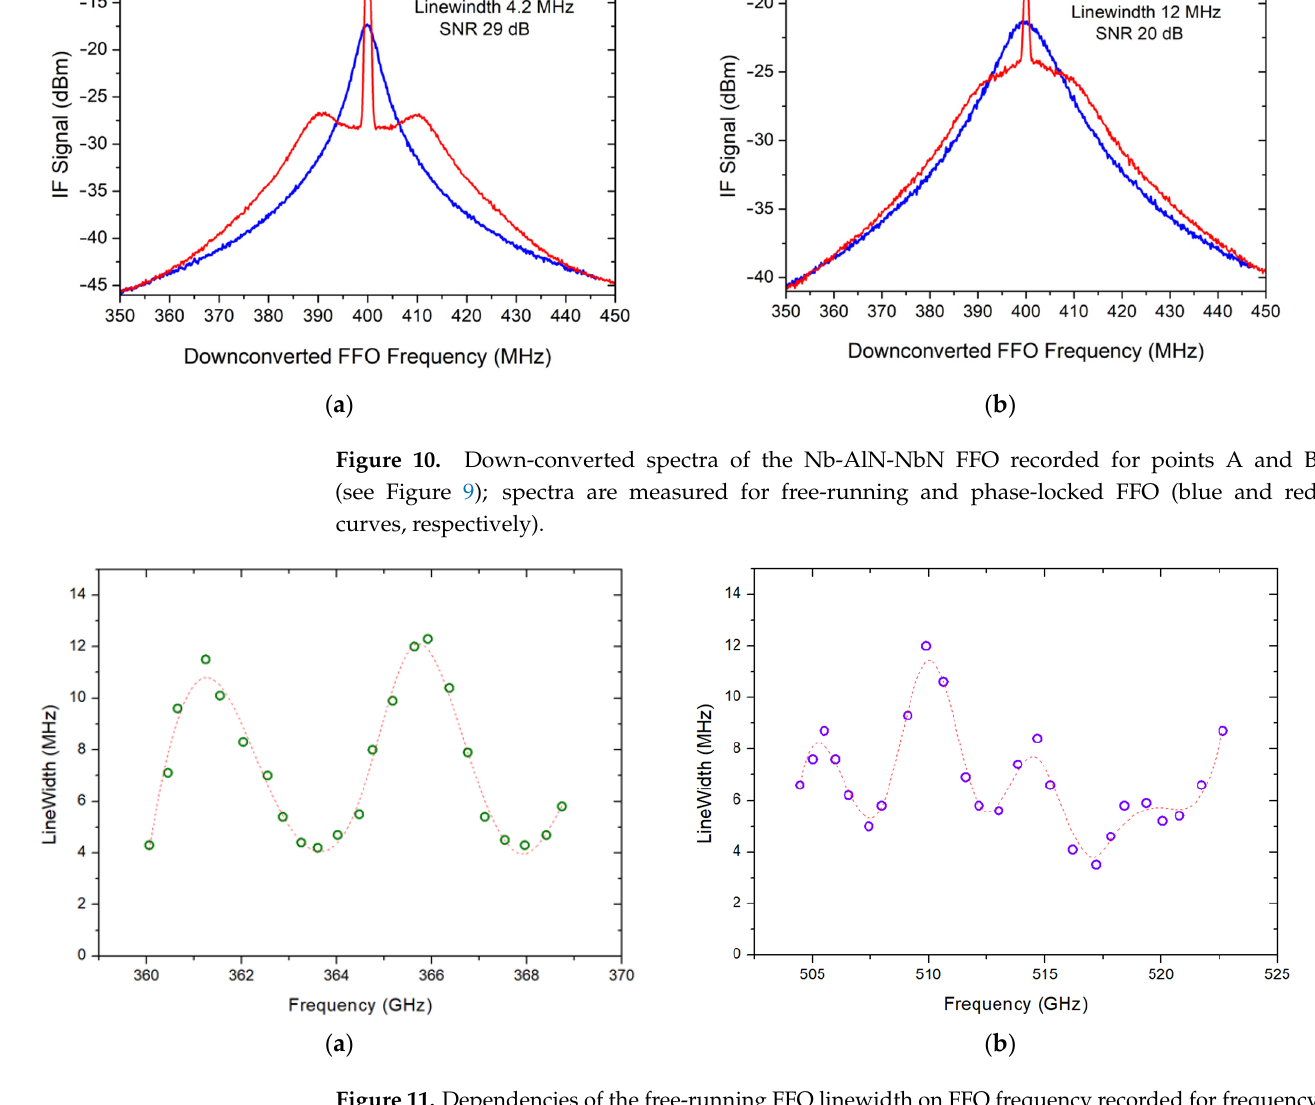
Figure 11. Dependencies of the free-running FFO linewidth on FFO frequency recorded for frequency ranges near 365 ( a ) and 515 GHz ( b ). Experimental points are connected by lines as a guide for the eye.